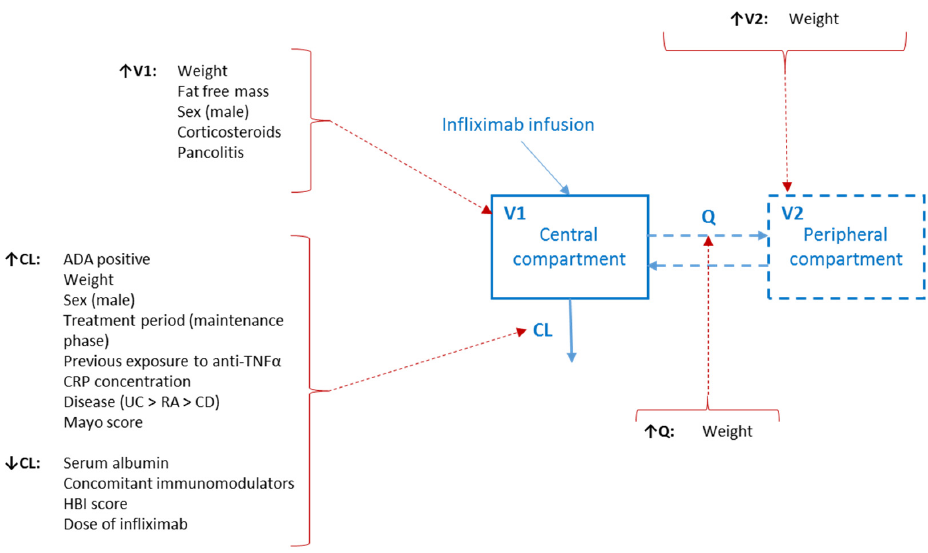
Figure 2. Impact of identified covariates in the 14 models on infliximab PK parameters. As one- or two-compartment PK models were developed, the second compartment and the associated mass transfer process are displayed with dashed lines. Abbreviations: ADA: Anti-drug antibodies; CD: Crohn’s disease; CL: Clearance; CRP: C-reactive protein; HBI: Harvey–Bradshow index; Q: Intercompartmental clearance; RA: Rheumatoid arthritis; TNF: Tumour necrosis factor; UC: Ulcerative colitis; V1: Volume of distribution of the central compartment; V2: Volume of distribution of the peripheral